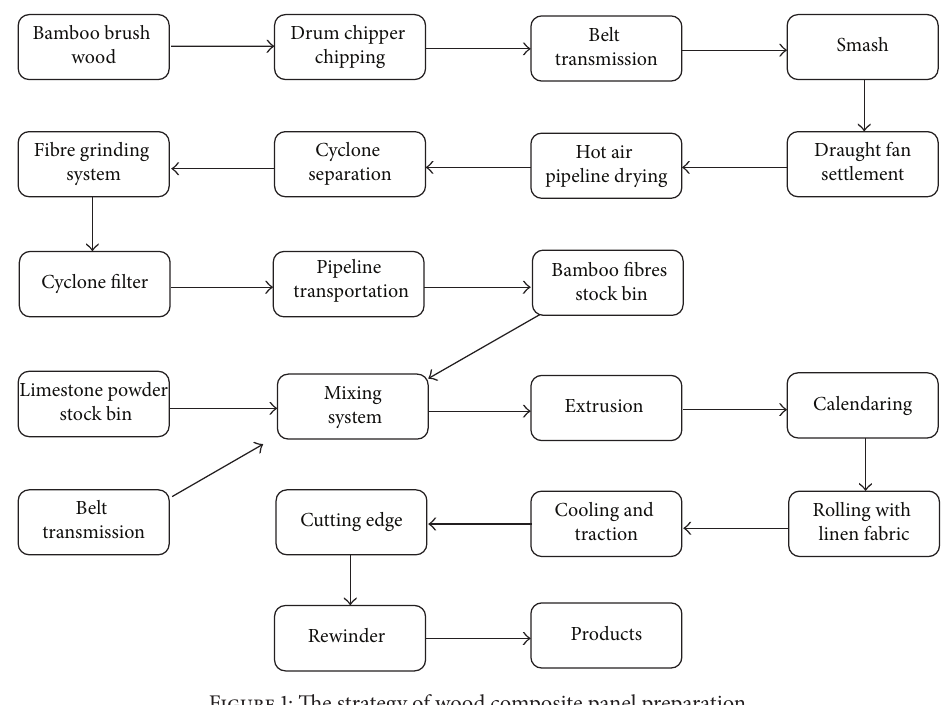
Figure 1: The strategy of wood composite panel preparation.